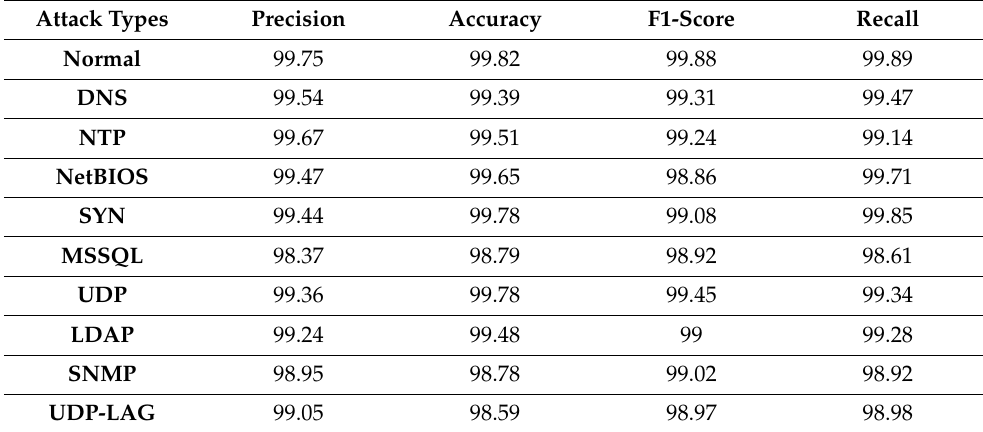
Table 9. Multi-class classification of the proposed approach on the CICIDS2019 dataset.